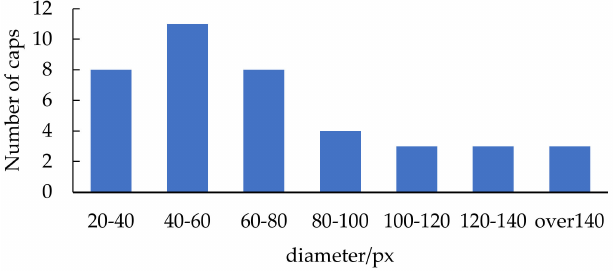
Figure 12. Diameter distribution of caps.